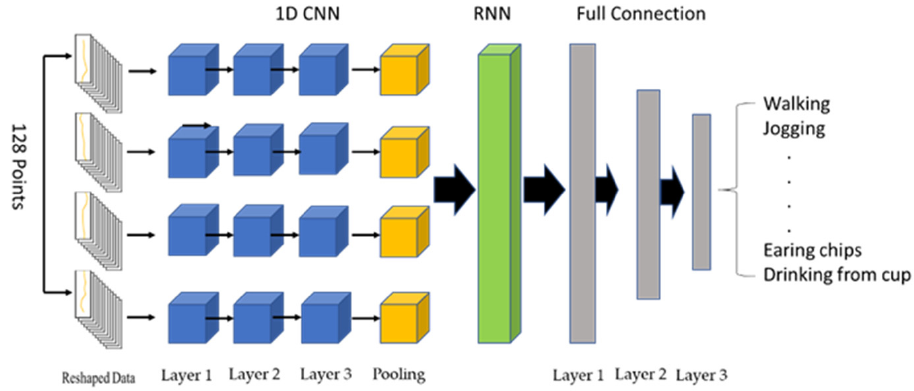
Figure 2. Structural diagram of the feature-extraction model.